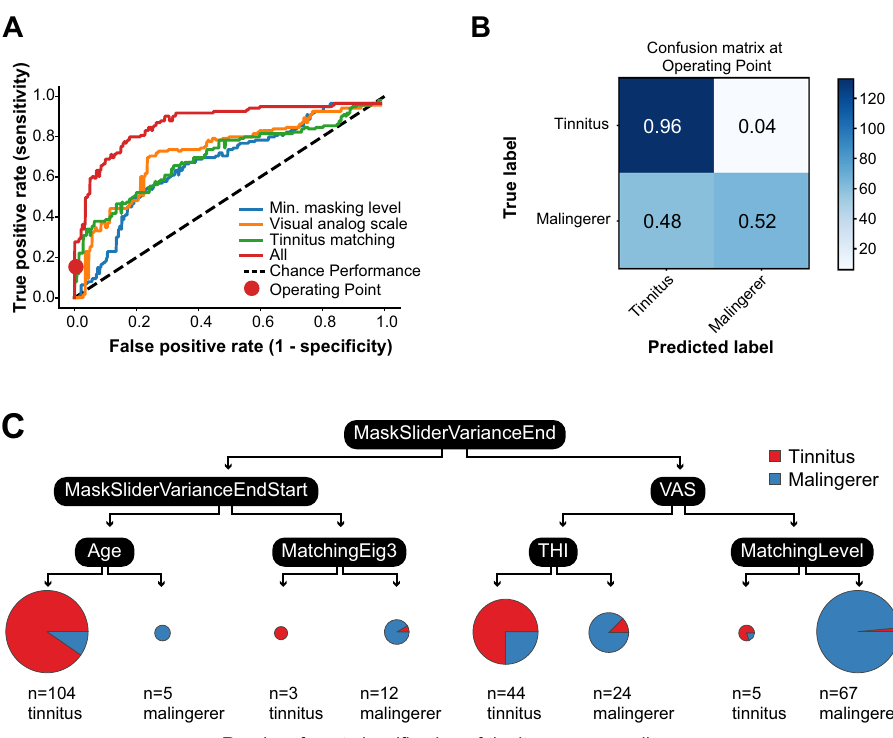
Fig. 5 Machine learning performance for binary classi fi cation of tinnitus vs. malingerers across behavioral tasks. A ROC for tinnitus versus malingerer classi fi cation on three psychoacoustic tasks (blue, green, yellow), and combined for all tasks (red) using a random forest. Combined performance accuracy was 81% (AUC = 0.88). B Confusion matrix for an operating point with a < 5% false alarm rate. C Example decision tree from the random forest classi fi er in panel ( A ), combining all features.